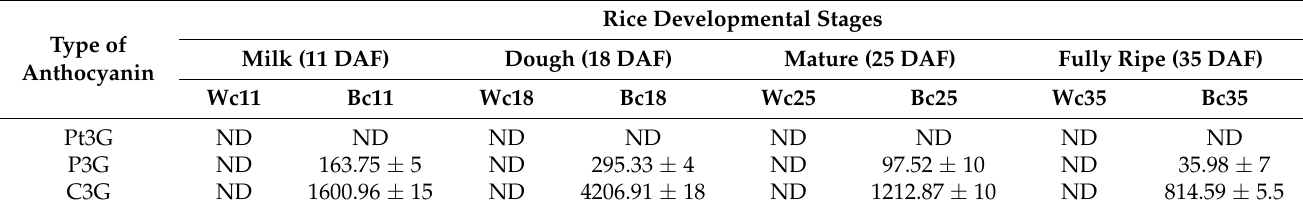
Table 1. Anthocyanin content ( µ g. g − 1 FW) in black and white caryopsis during the development stages. Type of